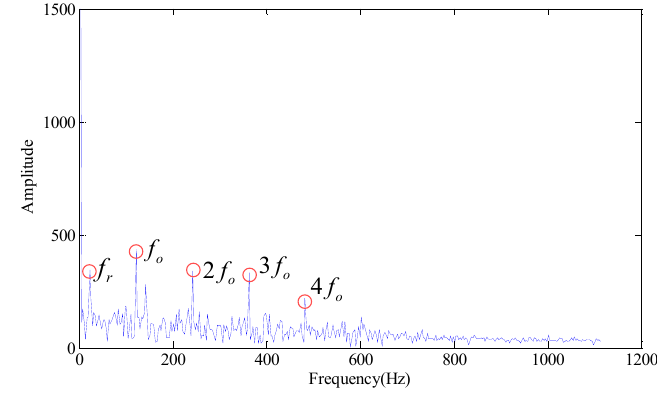
Figure 13. Envelope spectrum (singular values 1, 2, 5).